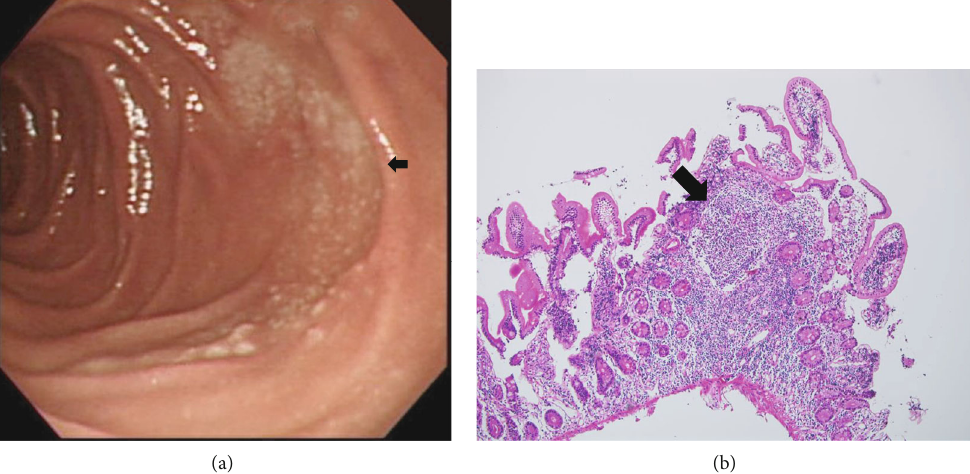
Figure 7: (a) White patches and nodules over the infrapapillary area (arrow). (b) Duodenal follicular lymphoma (arrow), featuring multiple lymphoid follicles in the lamina propria, composed of relatively uniform small lymphoid cells. Further immunohistochemical staining con fi rmed follicular lymphoma (CD20+/BCL2+/BCL6+/CD10+) (H&E,